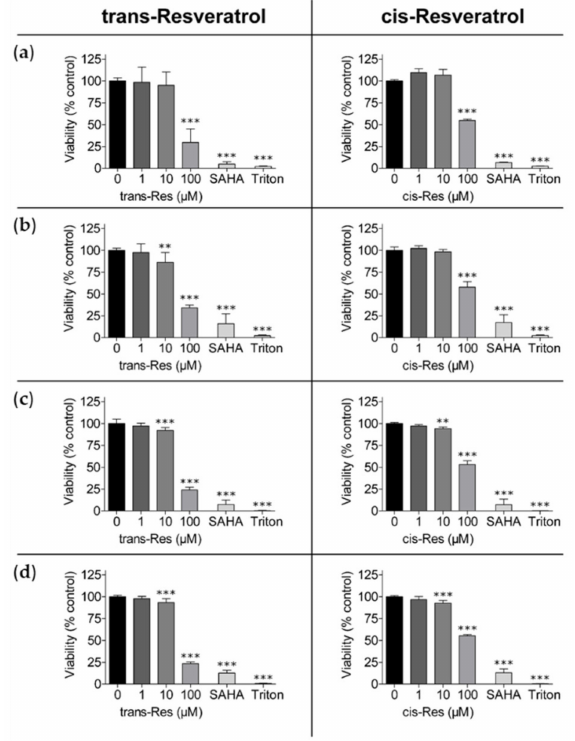
Figure 3. Reduced cell mass of hepatoma and colon carcinoma cells with different p53 status by trans- and cis-resveratrol shown by SRB assay. ( a ) HepG2, ( b ) Hep3B (hepatoma), ( c ) HCT-116, and ( d ) HCT-116/p53 ( − / − ) (colon carcinoma) cells were exposed to different concentrations of trans- and cis-resveratrol (1 µ M, 10 µ M, 100 µ M) for 72 h; 10 µ M SAHA served as positive control and 1% ( v / v ) Triton X-100 was added as a cell death control. The experiments were replicated in three independent experiments, each performed in triplicates. Results are shown as percentages compared to the untreated control. Error bars represent mean ± SD, statistical analysis with the Dunnet’s multiple comparison test, confidence interval 95%. **: p ≤ 0.01; ***: p ≤ 0.001. Res, resveratrol; SAHA, suberoylanilide hydroxamic acid; SRB, sulforhodamine